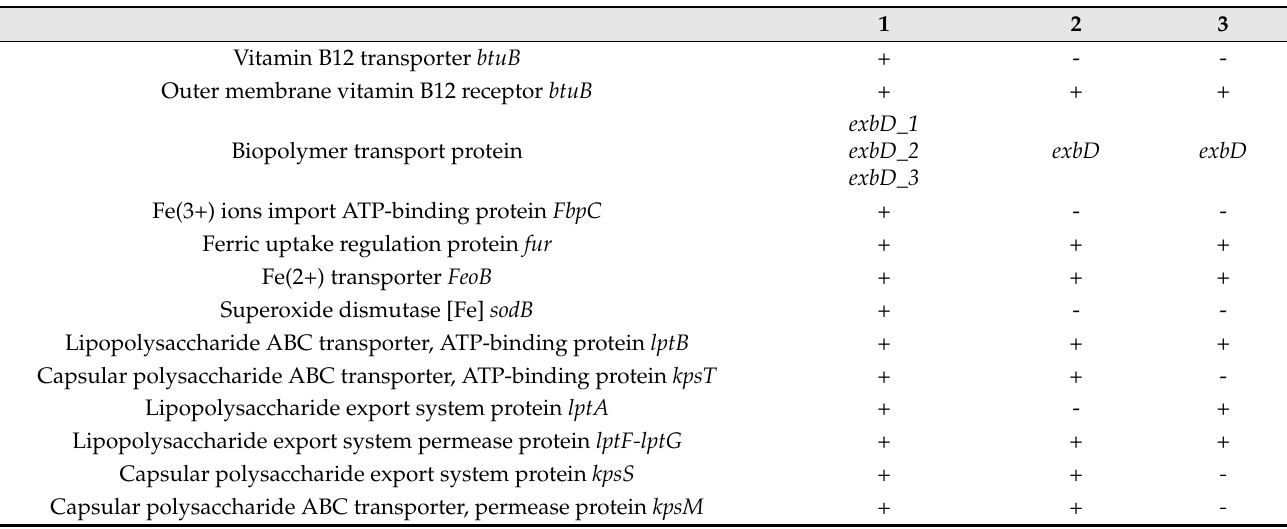
Table 9. Distribution of genes involved iron biomarker, vitamin B12 uptake, biopolymer transport protein, and polysaccharides proteins in 1, Pacificimonas pallium WHA3 T ; 2, Pacificimonas flava DSM 107612 T ; 3, Pacificimonas aurantium DSM 107782 T genomes using https://narrative.kbase.us/ accessed on 24 February